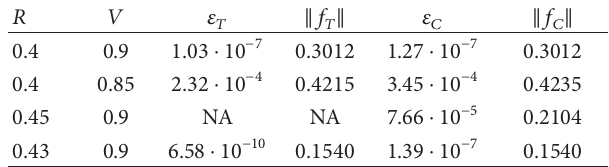
Table 1: Result enforcing 𝑅 and 𝑉